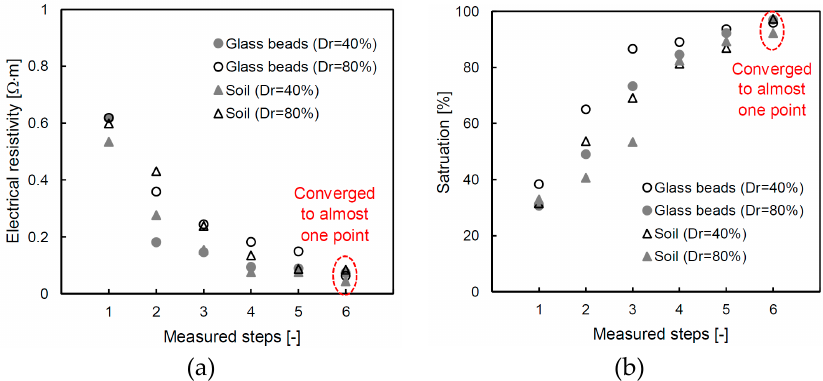
Figure 7. Converted results through the dielectric constant: ( a ) electrical resistivity; and ( b ) saturation.